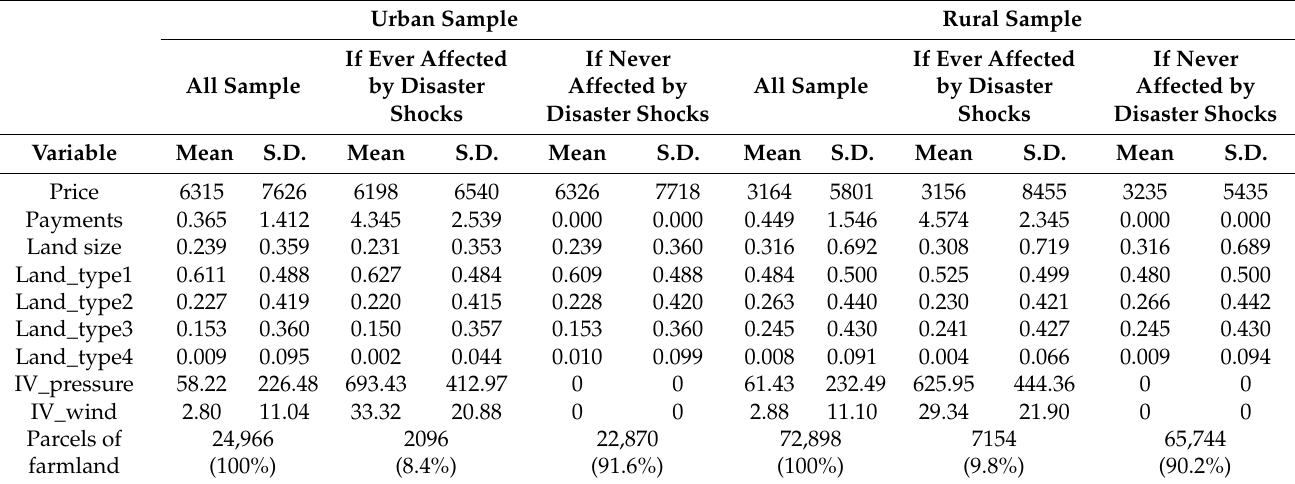
Table 3. Sample statistics of the selected variables by urban and rural areas. Urban Sample Rural